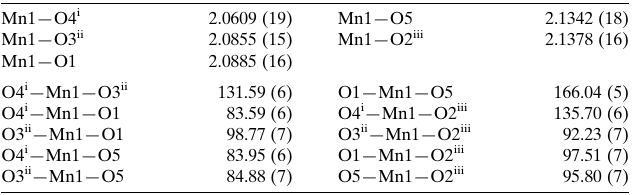
Selected geometric parameters (A˚ , (cid:5)